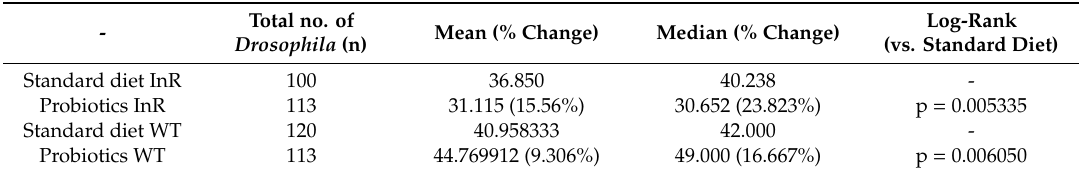
Table 1. Statistics for the survival curves. Total number of Drosophila , mean and median lifespan (percent change), and log-rank.